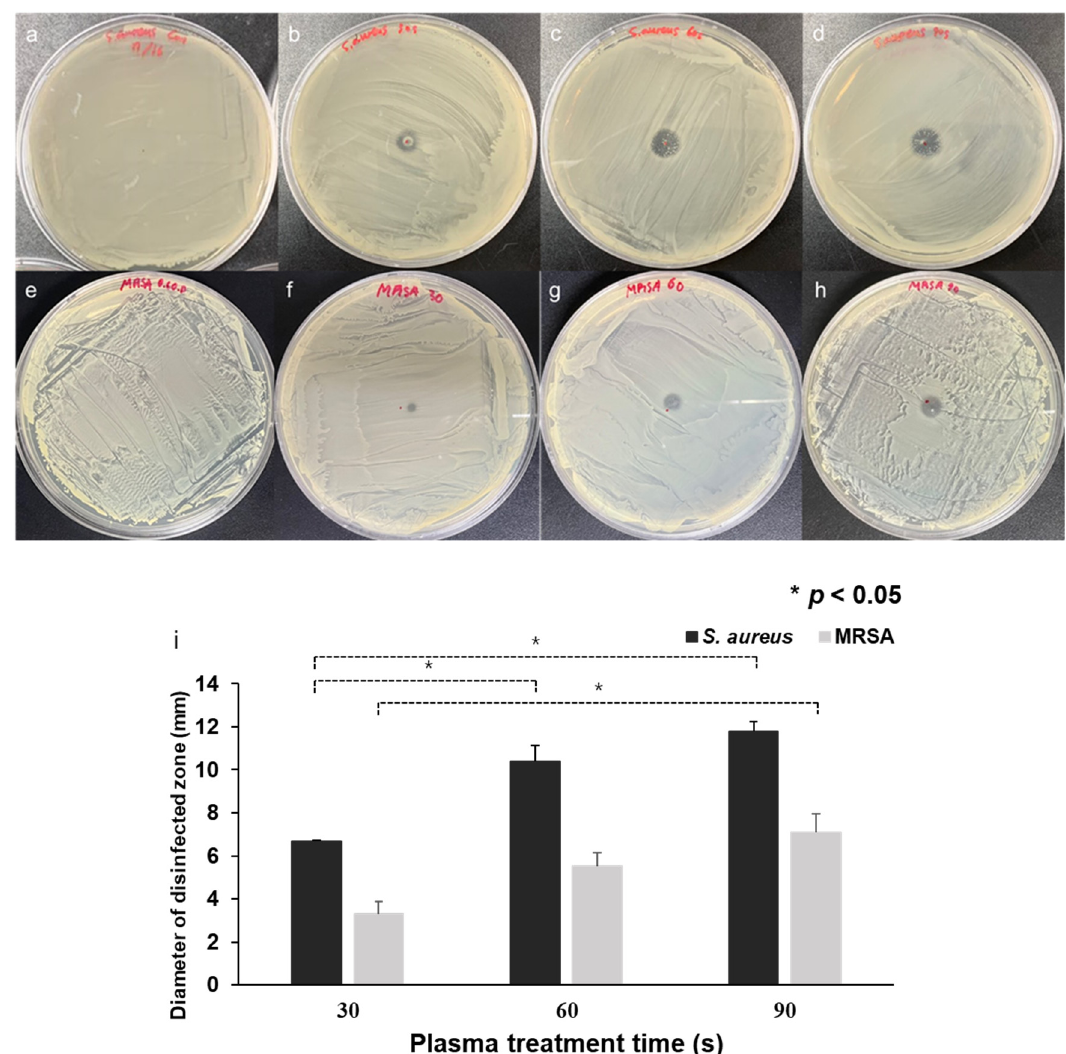
Figure 5. Clear zone test, according to the treatment time of CAPMP on ( a – d ) S. aureus and ( e – h ) MRSA spread on the agar plate with a diameter of 100 mm. ( a , e ) Control applied with Ar gas only for 90 s or ( b – d , f – h ) with plasma discharge for ( b , f ) 30, ( c , g ) 60, or ( d , h ) 90 s, ( i ) average and standard deviation of the clear zone diameter for S. aureus or MRSA with respect to the CAPMP treatment time ( n = 3), *: p < 0.05 by t -test between the groups.